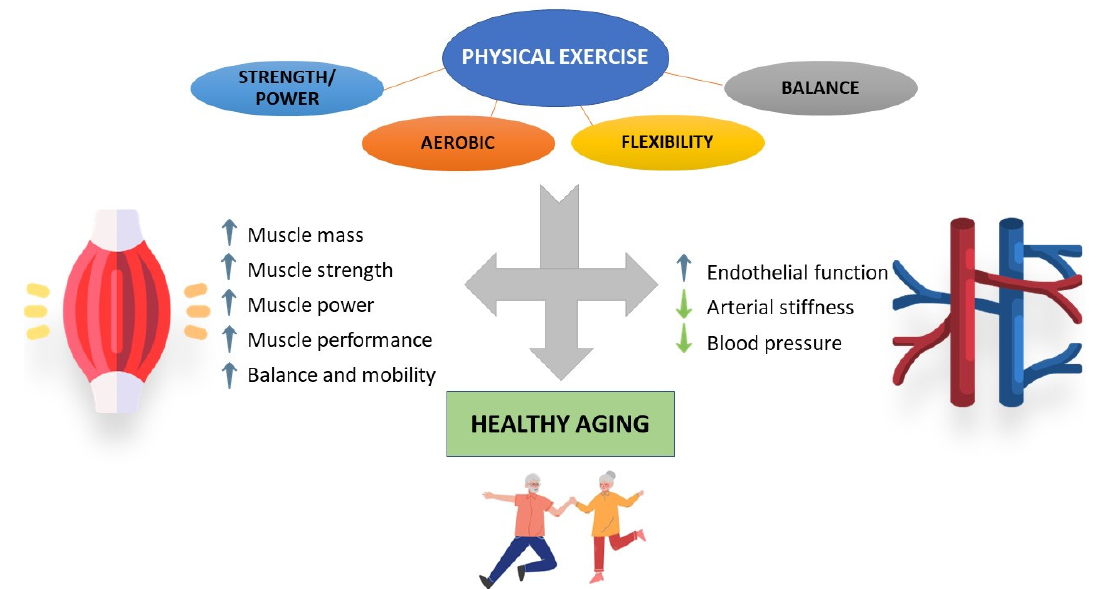
Figure 4. Physical exercise types as promoters of healthy aging. Different modalities of physical exercise (strength/power, aerobic, flexibility, and balance) exert benefits on multiple clinical variables through improving muscular and vascular functions. The expression of these benefits is associated with a healthy aging phenotype.